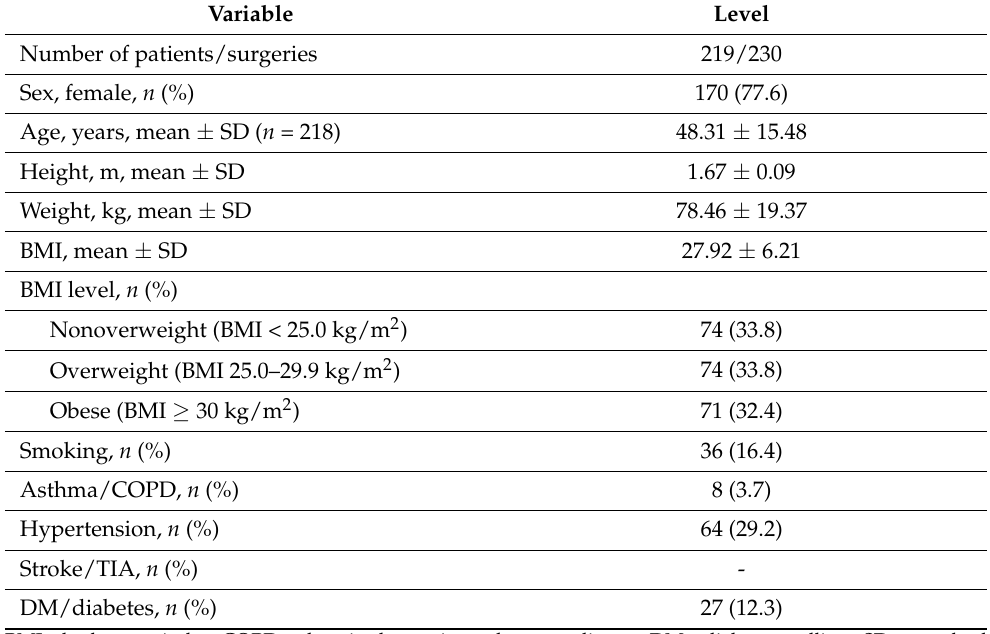
Table 1. Demographic characteristics of the patients ( n = 219).